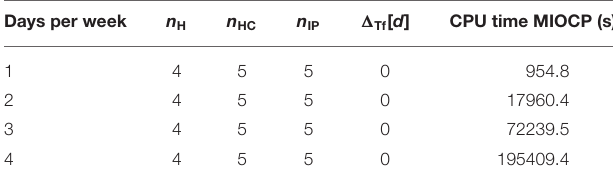
TABLE 4 | Results of integer approach run time demonstration. Days per